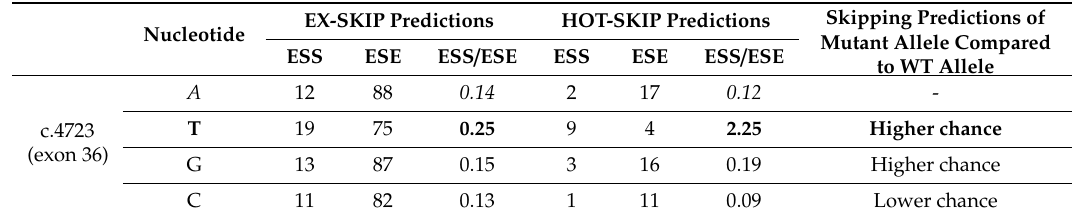
Table 1. Impact of the c.4723A > T mutation on exonic splicing silencer (ESS) and exonic splicing enhancer (ESE) motifs within the CEP290 exon 36.